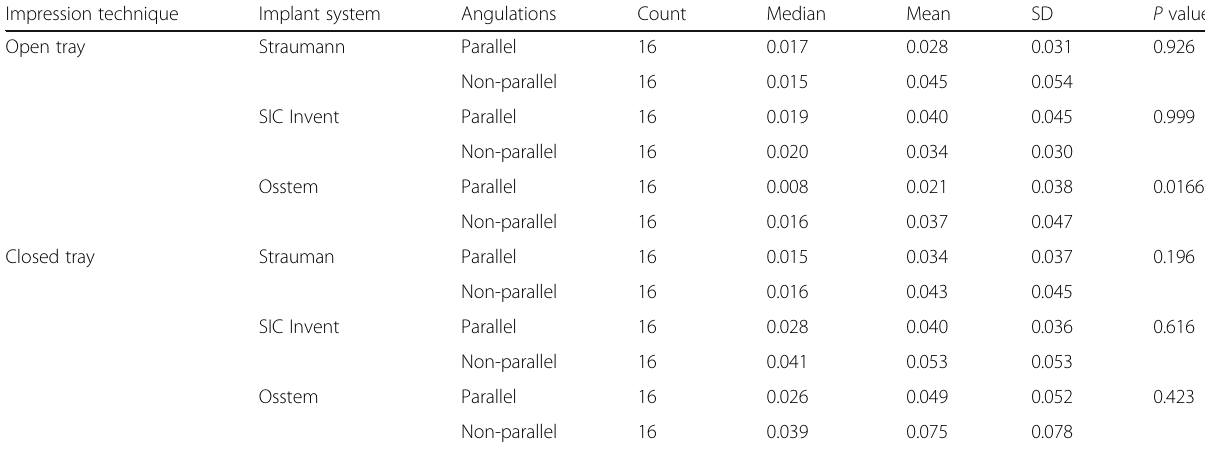
Table 3 Accuracy of open and closed tray impression techniques for both parallel and non-parallel implant systems Impression technique